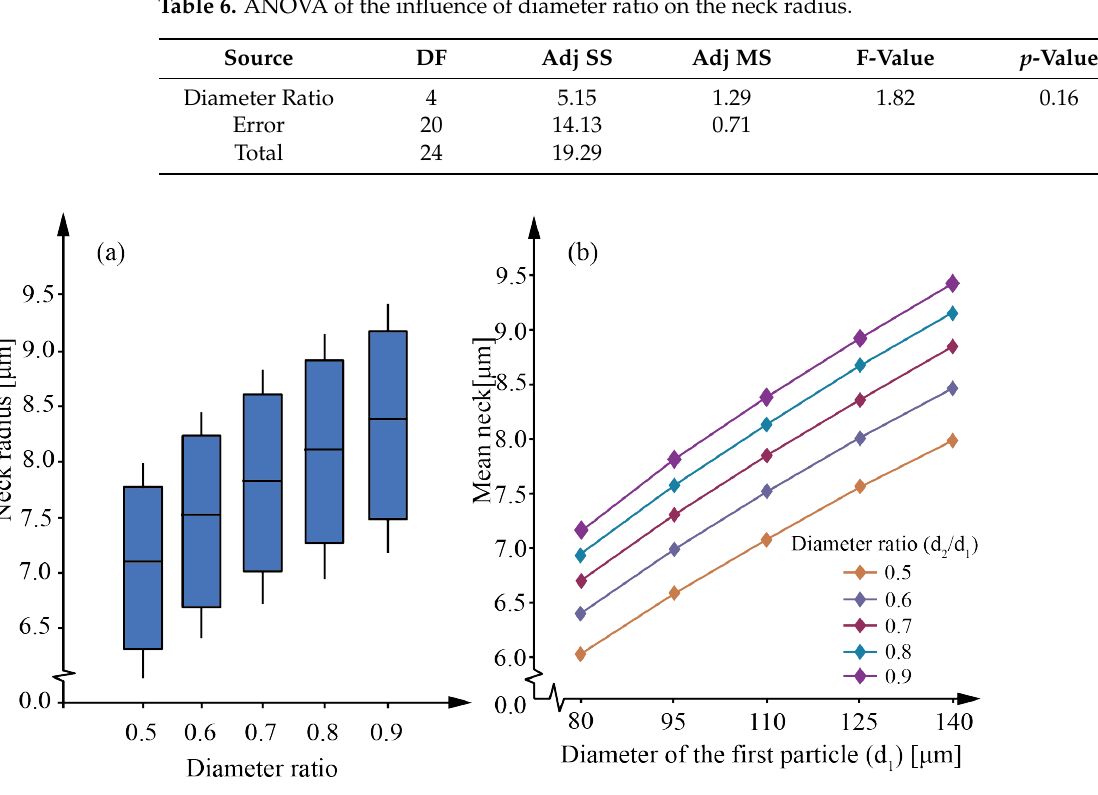
Table 5. ANOVA to test the influence of the diameter of the first particle (d 1 ) on the neck radius.